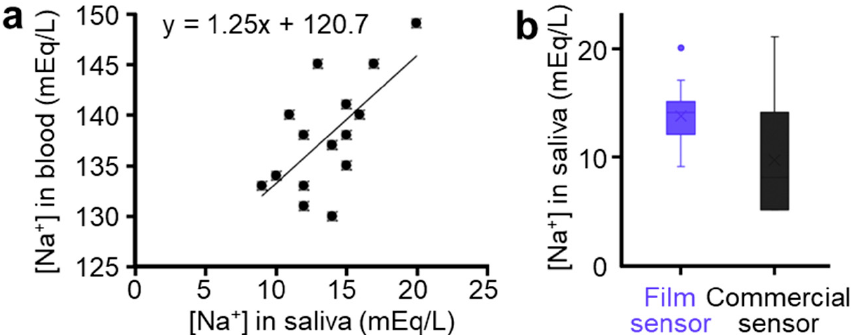
Figure 4. ( a ) Correlation of sodium ion levels measured from blood and saliva. ( b ) Correlation of sodium in levels measured from our sensor and commercial sensor.